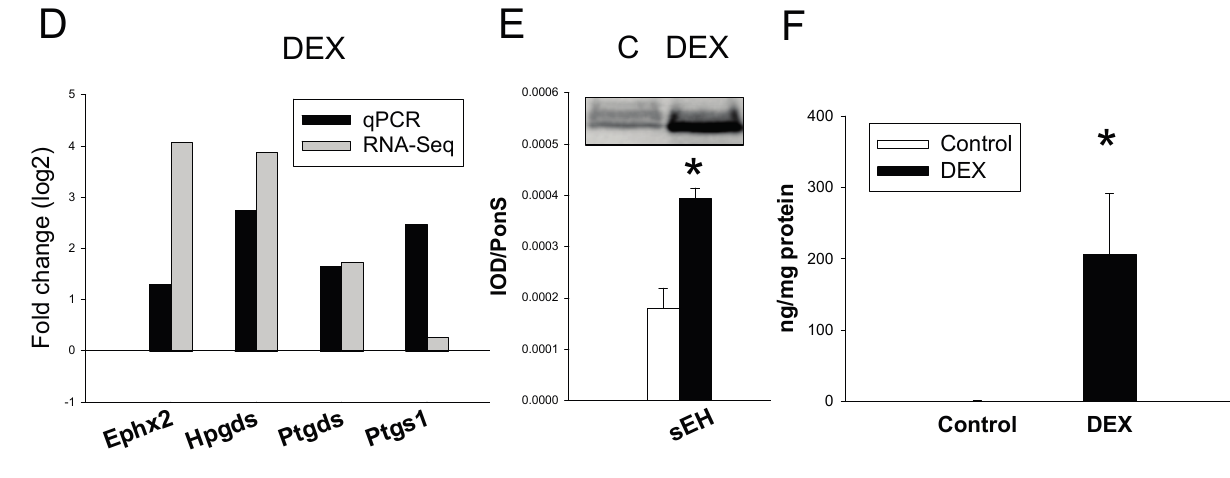
Figure 3. ( A ) Effects of HF on gene expression of arachidonic acid metabolism pathway in the kidney. Confirmatory analysis of kidney gene expression by qPCR in HF vs. control. Individual gene expression was determined by qPCR and expressed as fold change in log base 2 vs. control and graphed alongside fold change derived from RNA-Seq analysis; ( B ) Representative Western blots showing soluble epoxide hydrolase (SEH) protein (62 kDa) in offspring kidneys at 12 weeks of age. Relative abundance of renal sEH is quantified; ( C ) Effect of HF on renal 14,15-dihydroxyeicosatrienoic acid level; ( D ) Effects of DEX on gene expression of arachidonic acid metabolism pathway in the kidney. Confirmatory analysis of kidney gene expression by qPCR in DEX vs. control; ( E ) Representative Western blots showing sEH protein in offspring kidneys at 16 weeks of age; ( F ) Effect of DEX on renal 14,15-dihydroxyeicosatrienoic acid level. * p < 0.05 vs.